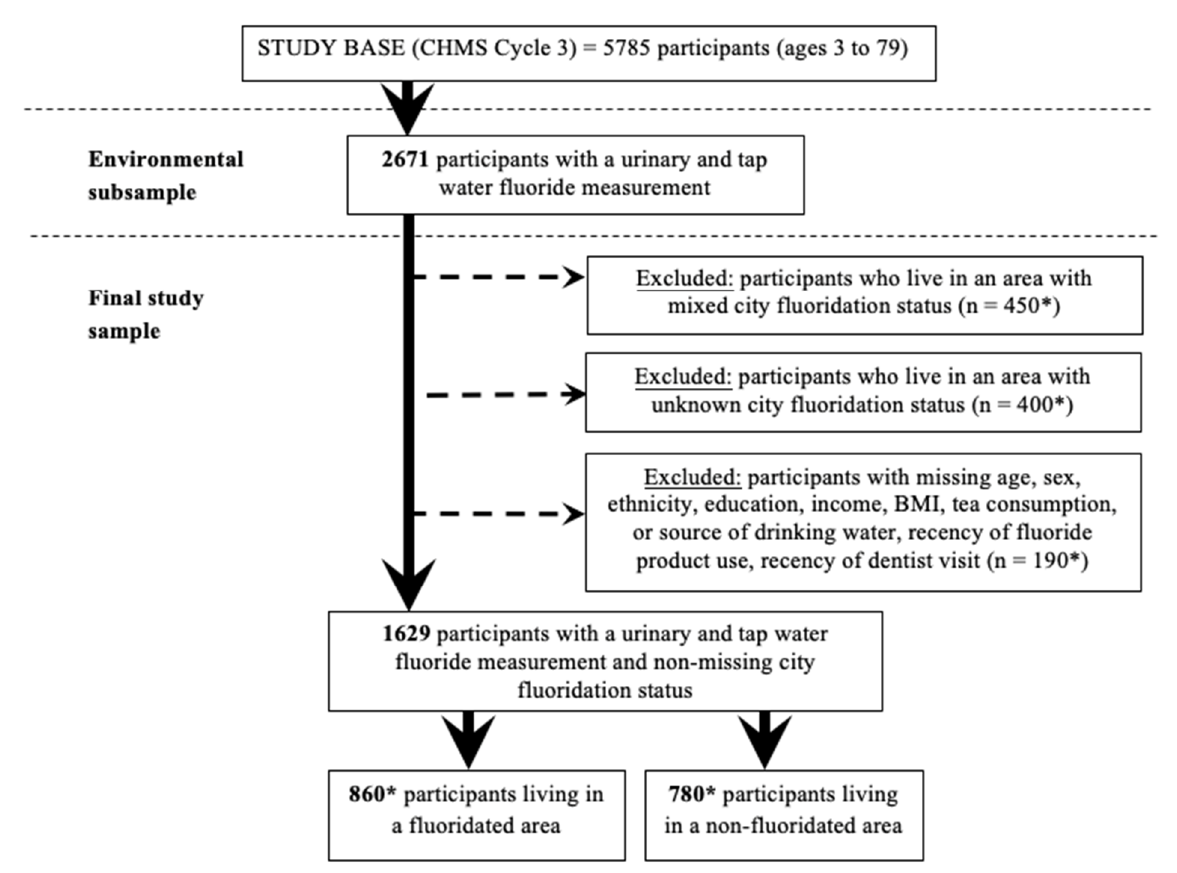
Figure 1. Flow chart of eligible participants in the study. Note: CHMS, Canadian Health Measures Survey; BMI, body mass index. * Signifies that the number has been rounded due to Statistics Canada vetting requirements.